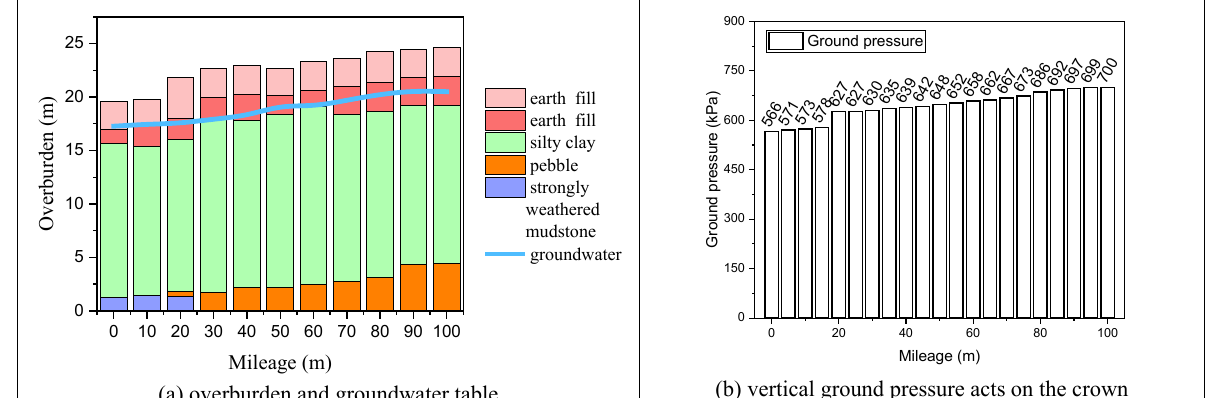
Figure 7 . Quantification of stratum sequences and ground